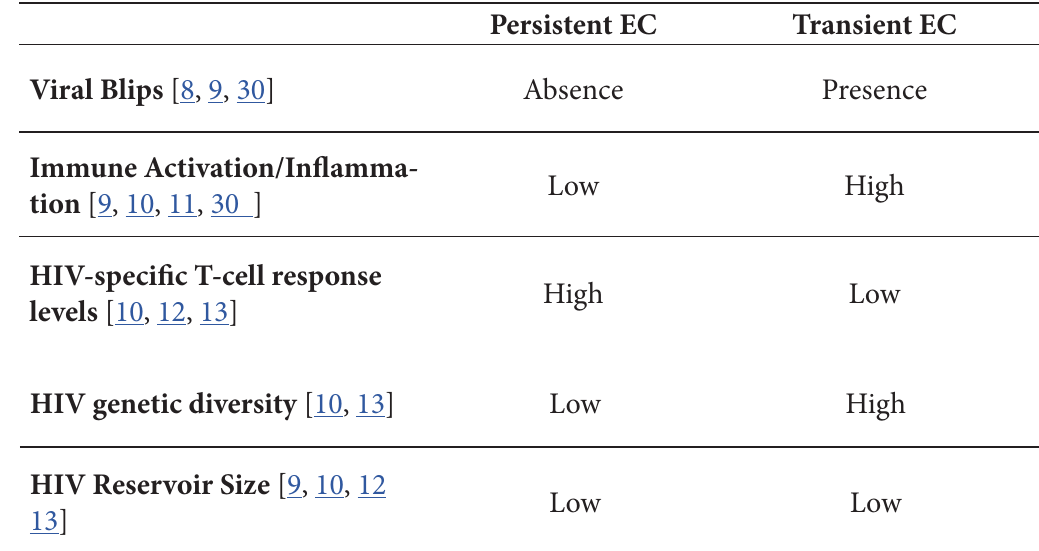
Table 1. Immunologic and virologic characteristics of persistent and transient elite